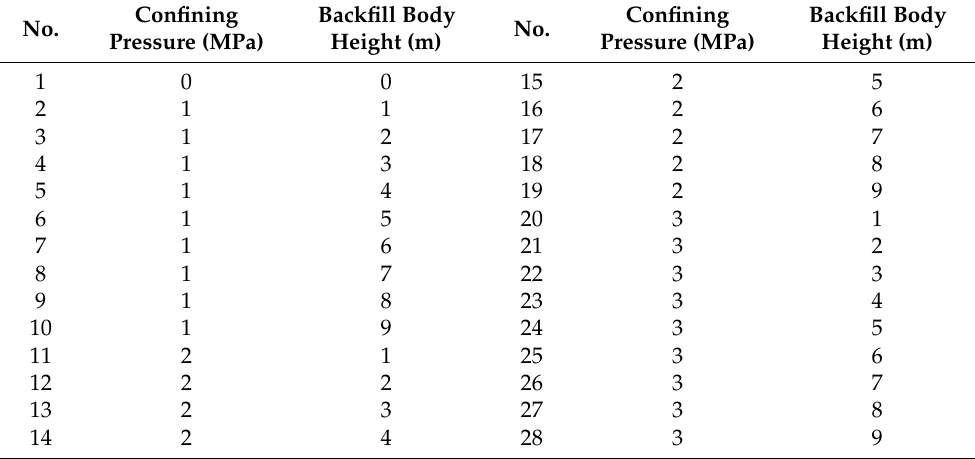
Table 4. Numerical simulation test parameters.